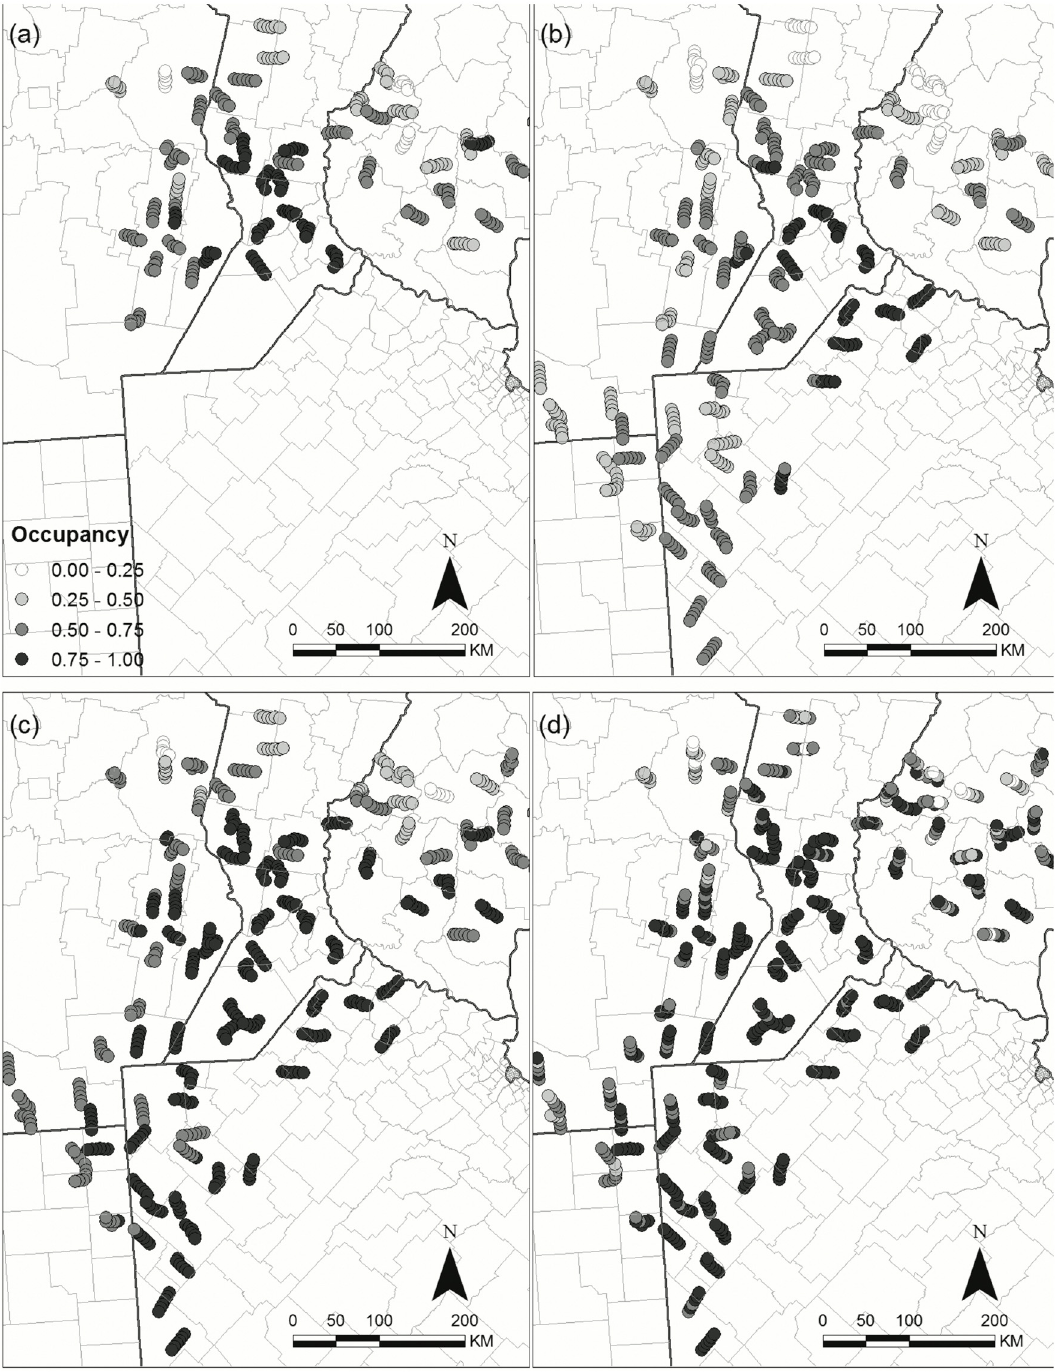
Fig 8. Picazuro Pigeon Patagioenas picazuro occupancy ( ^ ψ ) in the regional bird monitoring area in Argentina. Occupancy of the species is represented for (a) 2003, (b) 2006, (c) 2009, (d) 2012.